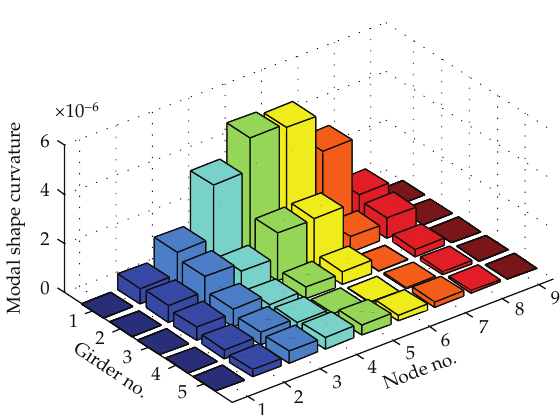
Figure 5: Identification results of element 4.